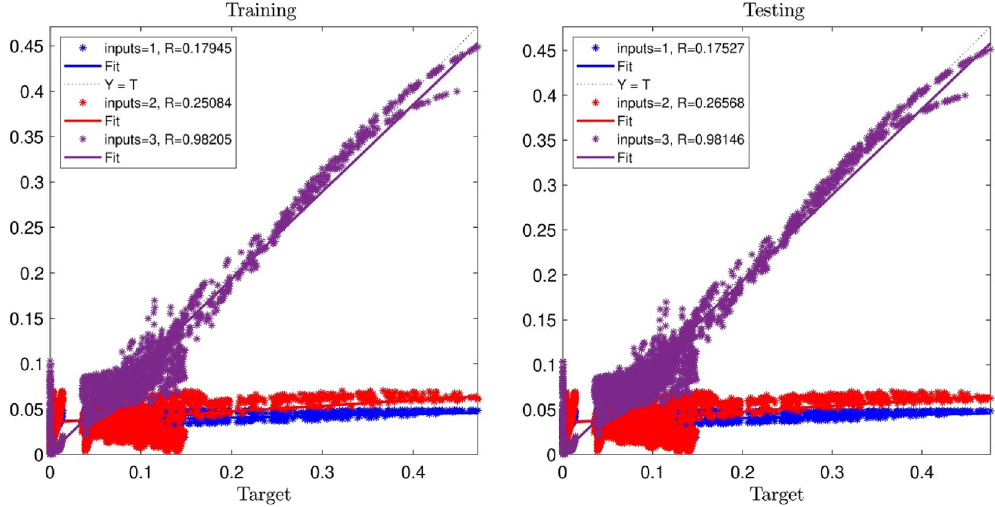
Figure 4. PSOFIS learning processes with considering changes in number of